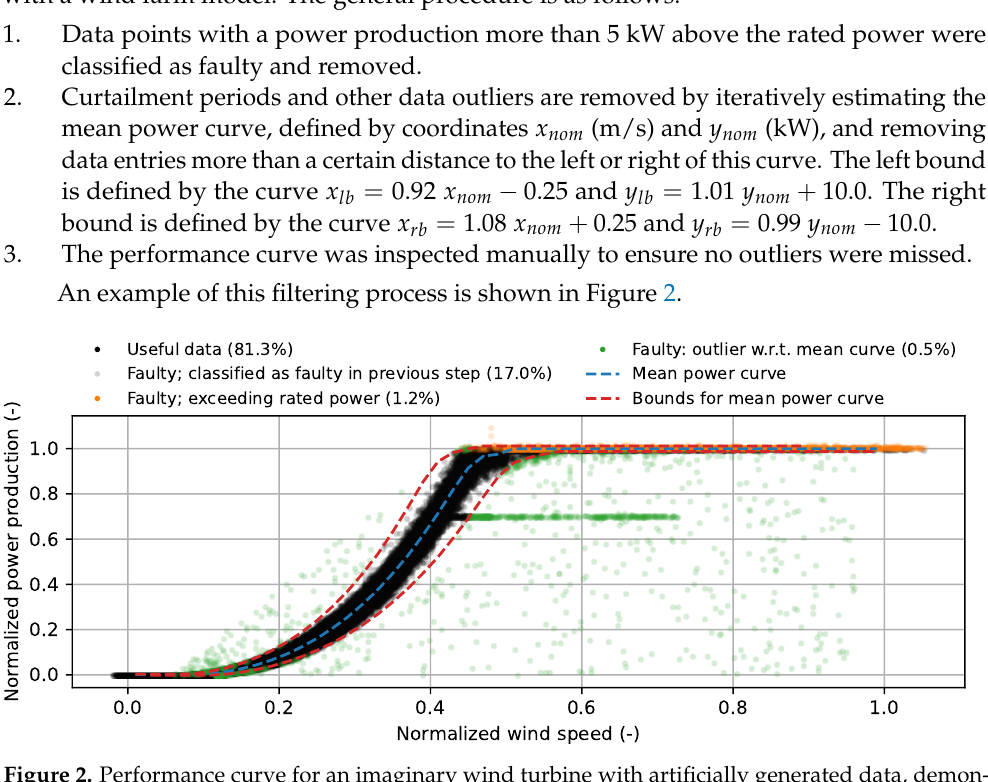
Figure 2. Performance curve for an imaginary wind turbine with artificially generated data, demon- strating the filtering process. The green dots indicate outliers and a curtailment region between normalized wind speeds 0.4 and 0.75, where the power is curtailed to 70% of the wind turbine’s rated value. Additionally, data points above rated wind speed but far below rated power are removed. Data marked in orange are all data with a power more than 5 kW above the rated value and are also